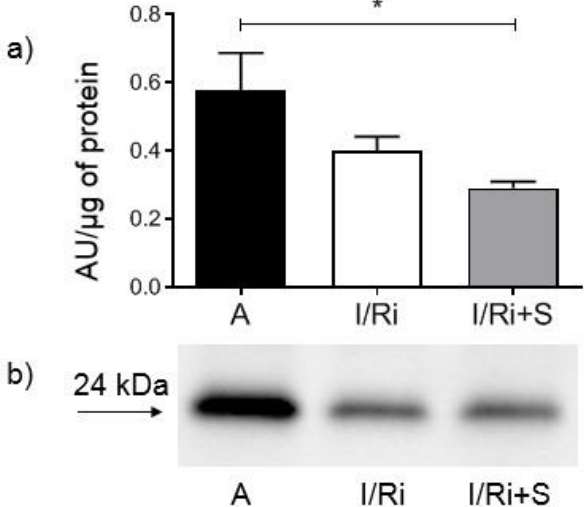
Figure 6. Effect of simvastatin on RhoA content in hearts subjected to ischemia-reperfusion ( a ) Anal- ysis of RhoA content in heart homogenates determined by Western blot. RhoA content in heart tissue in simvastatin-treated hearts subjected to ischemia-reperfusion was significantly lower in comparison to aerobically perfused hearts, while it did not differ between groups not treated with simvastatin. * p < 0.05, n = 5–6, ANOVA. ( b ) Representative Western blot showing RhoA level in heart homogenates. A—aerobic perfusion, I/Ri—ischemia-reperfusion injury, I/Ri + S—hearts from IR injury model treated with